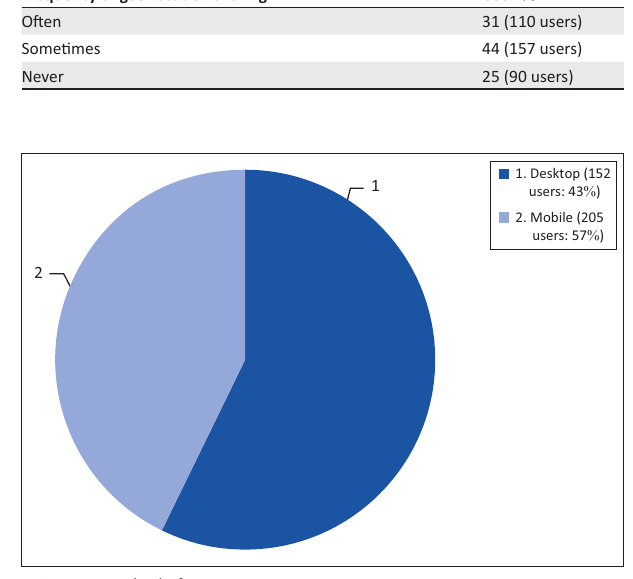
FIGURE 3: Availability of user details. FIGURE 4: Method of